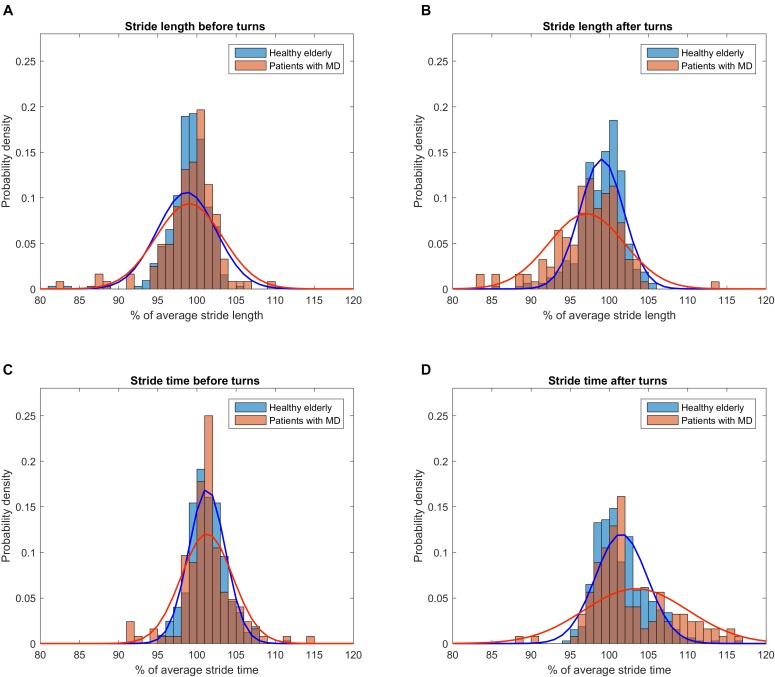
Distribution of gait parameter values right before and after turns relative to individual overall average. To account for different cohort sizes and number of turns, histograms were normalized for probability density. Parabolas depict the probability density function derived from means and standard deviations of the respective subset of strides. (A) Distribution of stride length values before turns for patients (red) and healthy subjects (blue). (B) Distribution of stride length values after turns. Note the wider spread of stride length values in the cohort of patients and the trend toward a shorter stride length compared to healthy subjects. (C) Distribution of stride time values before turns. (D) Distribution of stride time values after turns. Note the wider spread of stride time values in the cohort of patients and the trend toward a longer stride time compared to healthy subjects.